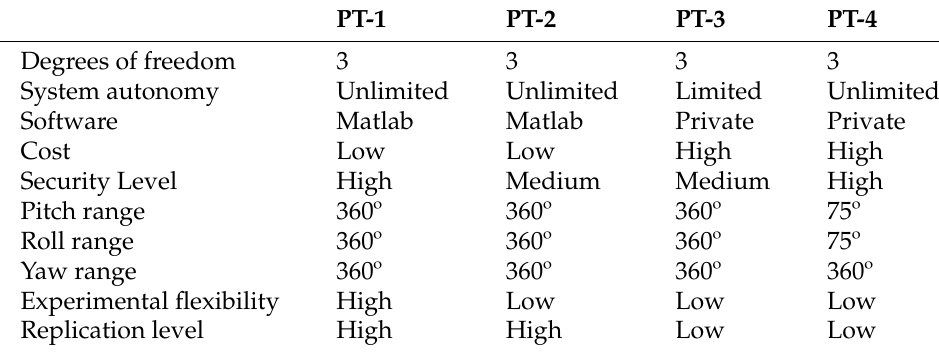
Table 2. Feature comparison between existing test platforms for